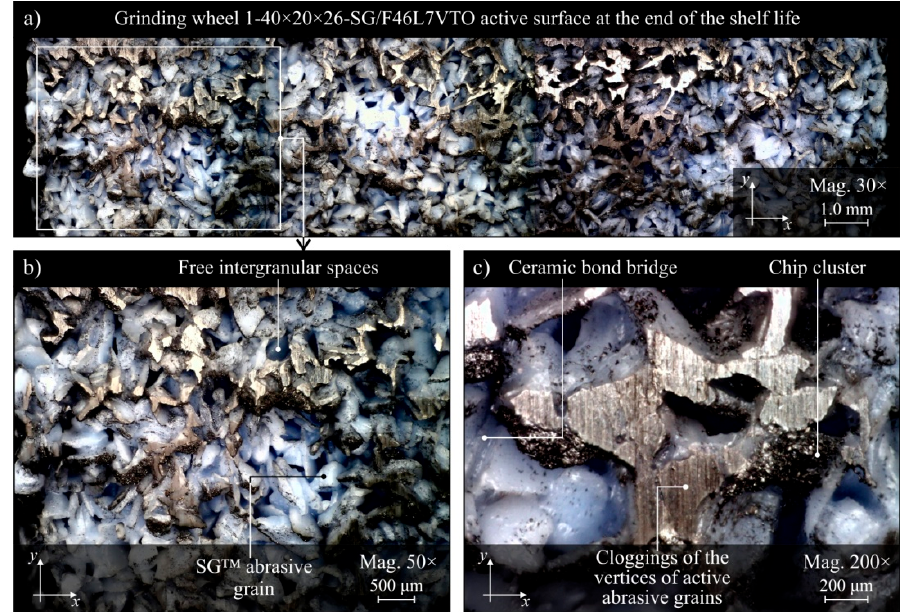
Figure 15. Microscope images of the grinding wheel active surface after machining using CAG for cooling of the machining zone, recorded with the Dino-Lite Edge AM6715MZT digital measuring microscope: ( a ) magnification 30 × ; ( b ) magnification 50 × ; ( c ) magnification 200 × .